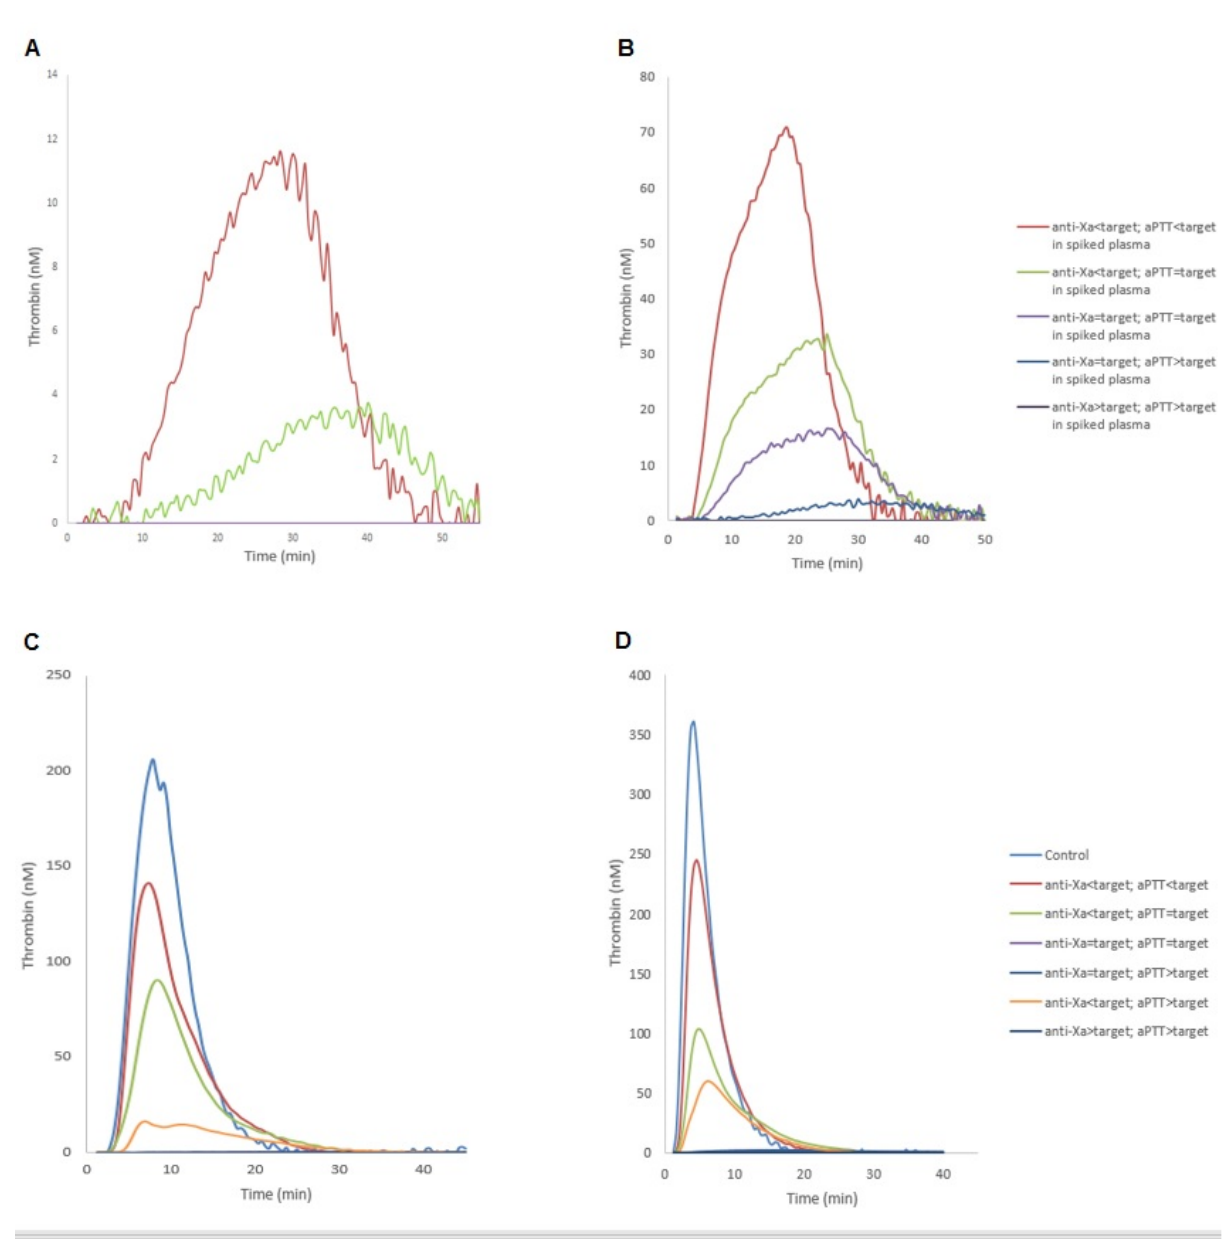
Figure 2. Thrombin generation curve according to the levels of anti-Xa activity and aPTT in spiked heparin plasma ( A , B ) and in ICU patients ( C , D ). Corresponding to 5 pM ( A , C ) and 20 pM ( B , D ) of tissue factor to start reaction. The control group of ICU patients consisted of pooled plasmas without anticoagulant treatment. aPTT: aPTT: activated partial thromboplastin time; ICU, intensive care unit; TF, tissue factor.